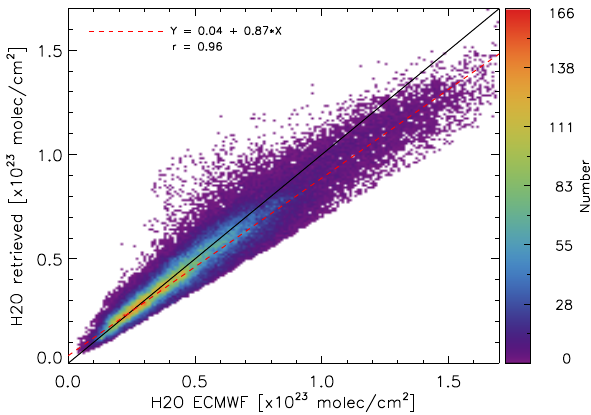
Figure 14. Correlation diagram of the H 2 O total columns re- trieved by SCIAMACHY vs. the coinciding H 2 O total columns Fig. 14. Correlation diagram of the H 2 O total columns retrieved from ECWMF for all measurements in 2003 above the Sahara (lat- by SCIAMACHY versus the coinciding H 2 O total columns from itude 15 to 30 ◦ , longitude − 15 to 30 ◦ ). The red dashed line shows ECWMF, for all measurements in 2003 above the Sahara (latitude a linear regression, while “ r ” indicates the linear Pearson’s correla- 15 ◦ to 30 ◦ , longitude 15 ◦ to 30 ◦ ). The red dashed line shows a tion − linear regression, while “r” indicates the linear Pearson’s correlation coefficient.